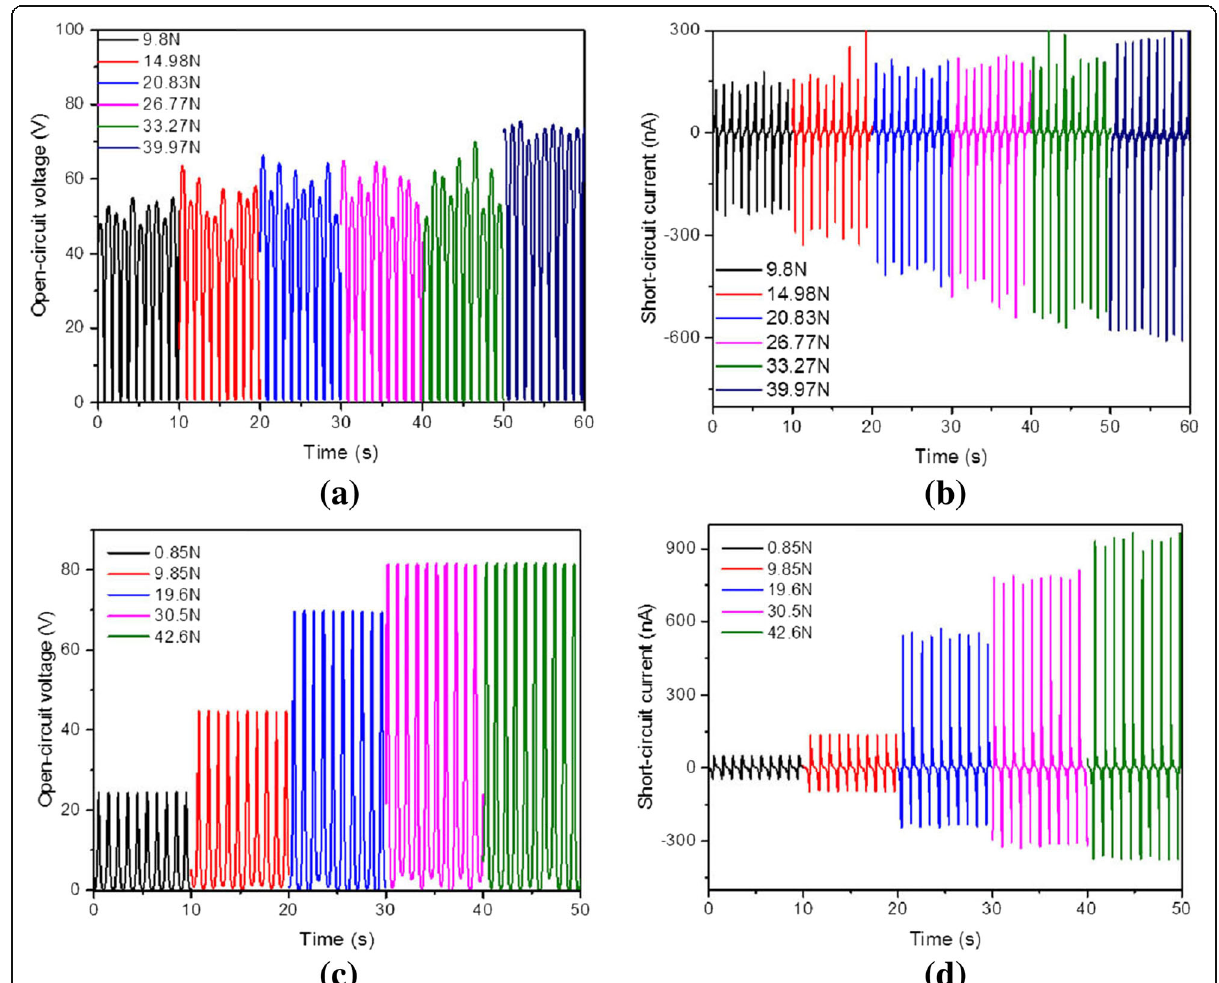
Fig. 4 The electrical properties for surface nanostructures. The results for grating ( a , b ) and a nanopillar array ( c , d ) are